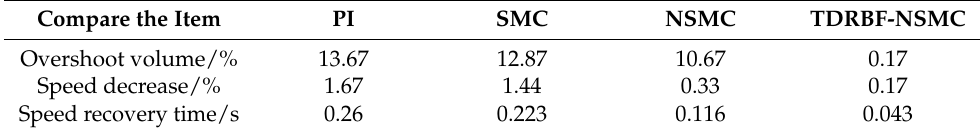
Table 2. Comparison of data under constant load start and increasing load perturbation.